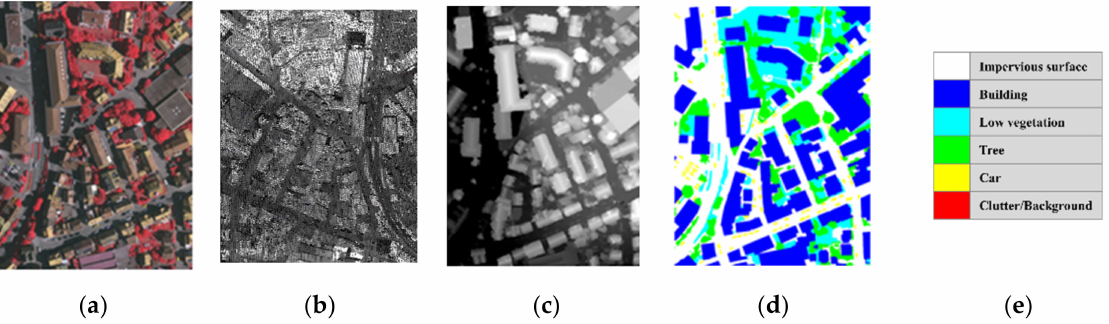
Figure 7. Examples of ISPRS Vaihingen datasets for 2D semantic labeling: ( a ) IR true orthoimages; ( b ) LiDAR data; ( c ) DSM; ( d ) land cover label data (i.e., ground truth); ( e ) land cover categories with 6 class labels.